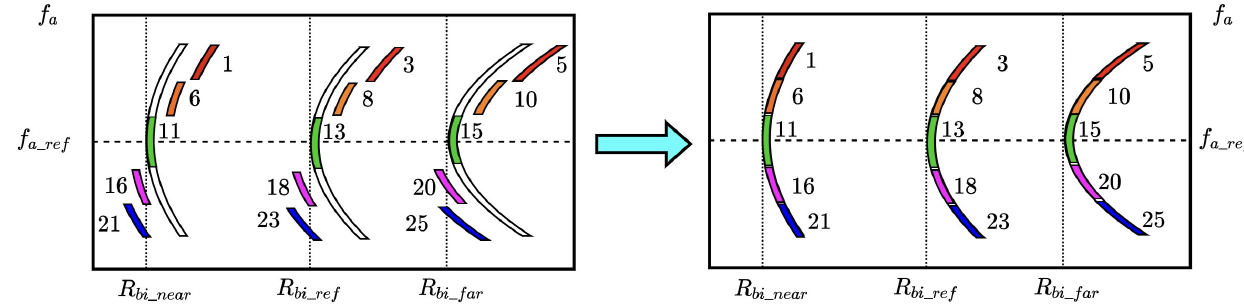
Figure 5. The azimuth variance correction